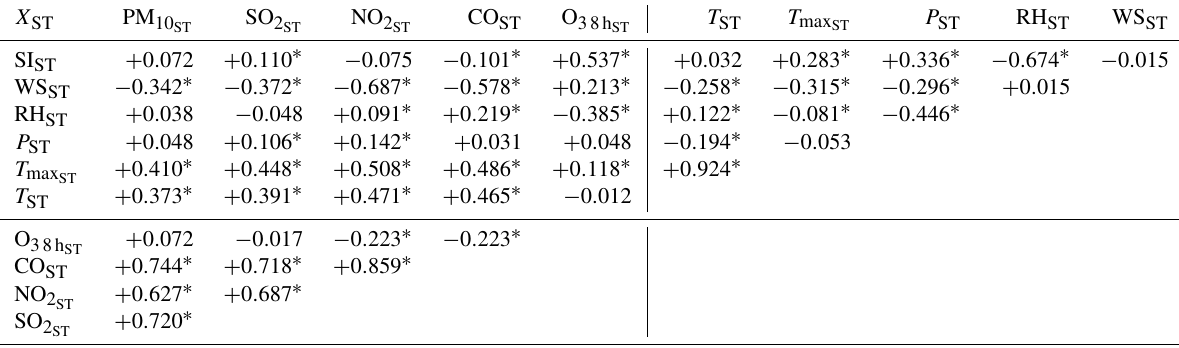
Table 3. Correlation coefficients ( r ) among short-term components of each pollutant and meteorological variable in Seoul for the period between February 1999 and November